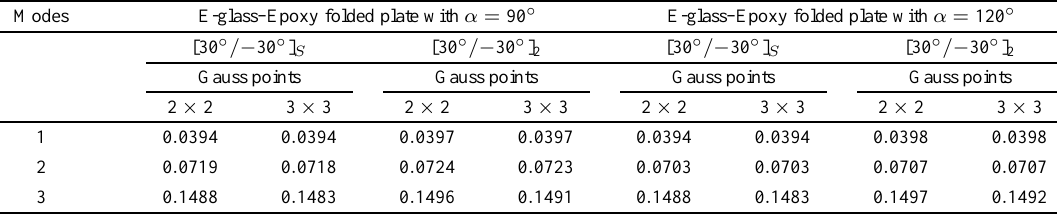
Non-dimensional frequencies for single-fold laminated composite folded plates with 2-point and 3-point integration of mass